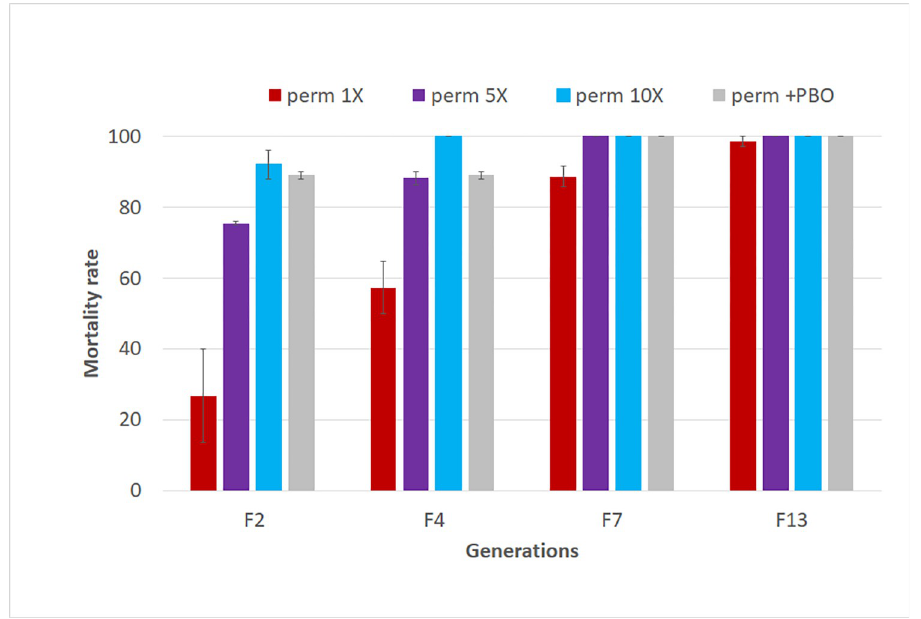
Fig 3. Susceptibility profile of the hybrid MYG/KIS to permethrin over 13 generation in the absence of selection. Results of WHO tube bioassays with permethrin 1x, 5x and 10x and PBO+ permethrin 1x. Results are average of percentage mortalities ± SEM of four